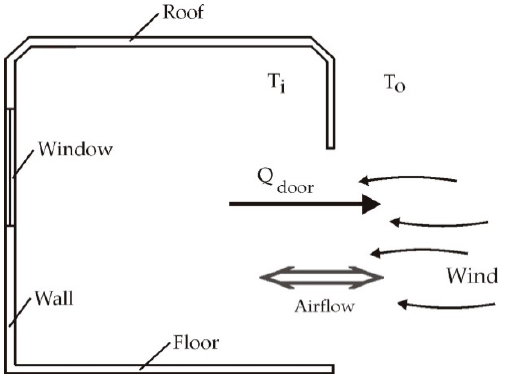
Figure 6. Schema cross-section through the bus structure for an open door.